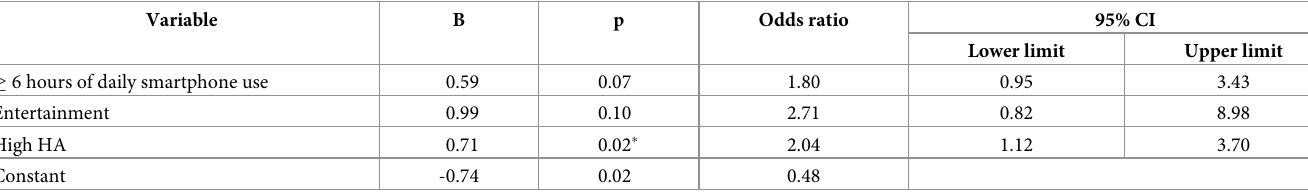
Table 6. Results of the multivariate logistic regression analysis.